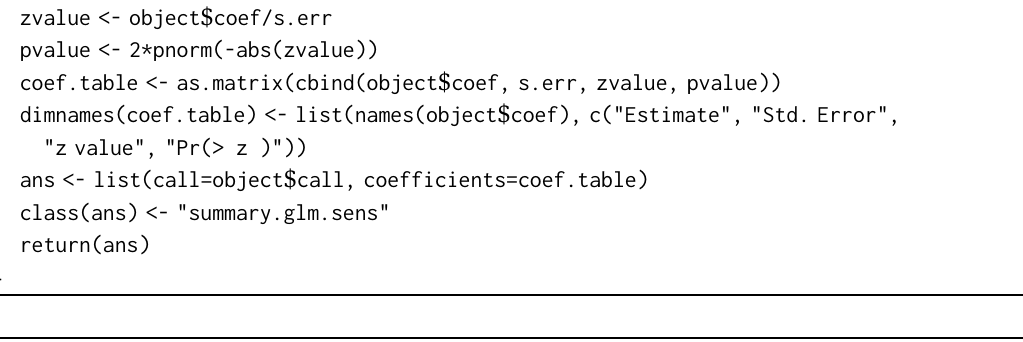
coef.table <- as.matrix(cbind(object $ coef, s.err, zvalue,